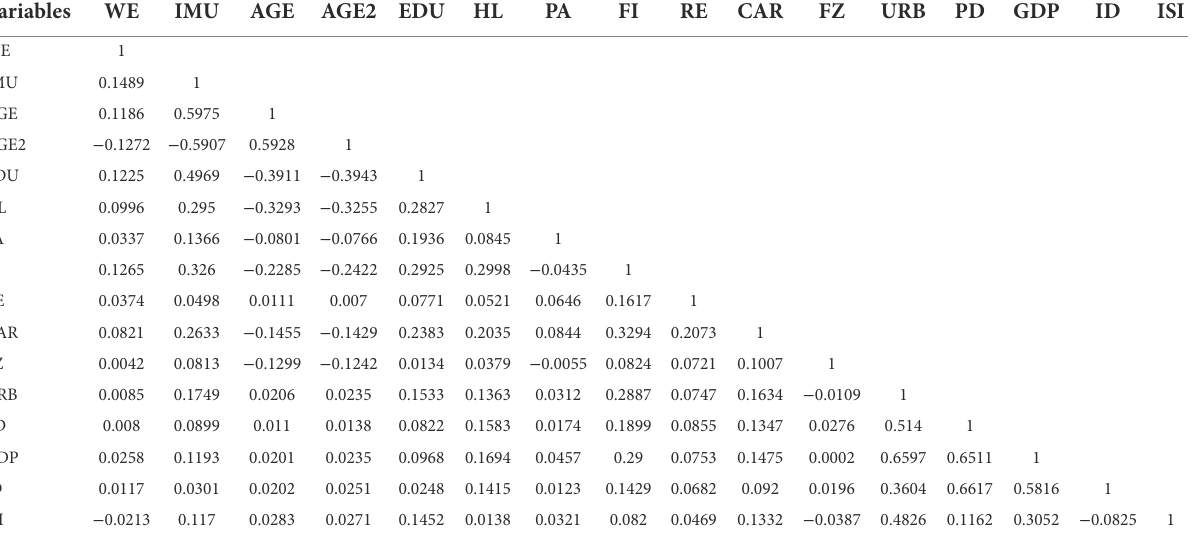
TABLE 2 Correlation test.